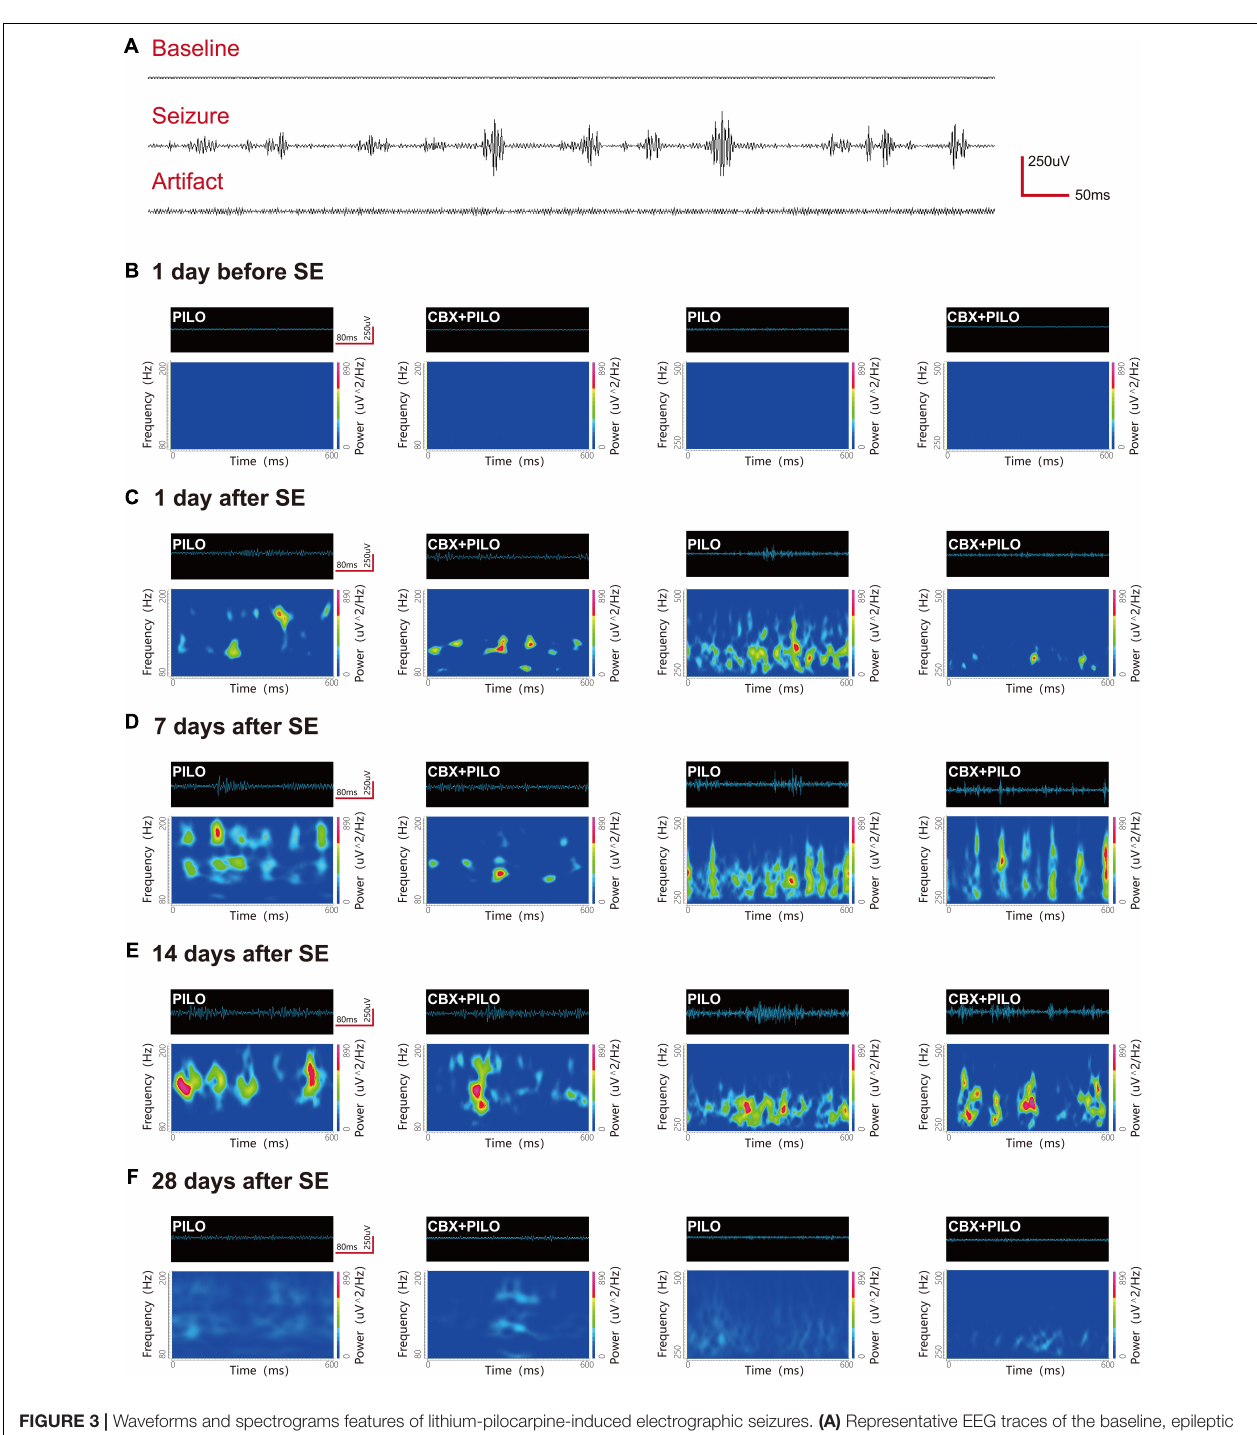
FIGURE 3 | Waveforms and spectrograms features of lithium-pilocarpine-induced electrographic seizures. (A) Representative EEG traces of the baseline, epileptic seizure, and an artifact. (B–F) Waveforms and spectrograms showing the spectral and temporal characteristics of ripples (80–200 Hz) and FRs (250–500 Hz) in the PILO and CBX + PILO groups at 5 time points [1 day before SE, and 1, 7, 14, and 28 days after SE]. The waveforms were filtered with a band pass filter of 80–200 Hz and 250–500 Hz. The spectrograms reflect the accumulated time-frequency representations of the corresponding waveforms. The data demonstrate that the initiation of seizures was associated with an increase of HFOs energy, and that pretreatment with CBX could reduce HFOs energy and the degree of seizures. The HFOs are characterized by rhythmic bursts, which are significantly different from systematic artifacts, such as power line noise and its harmonics.